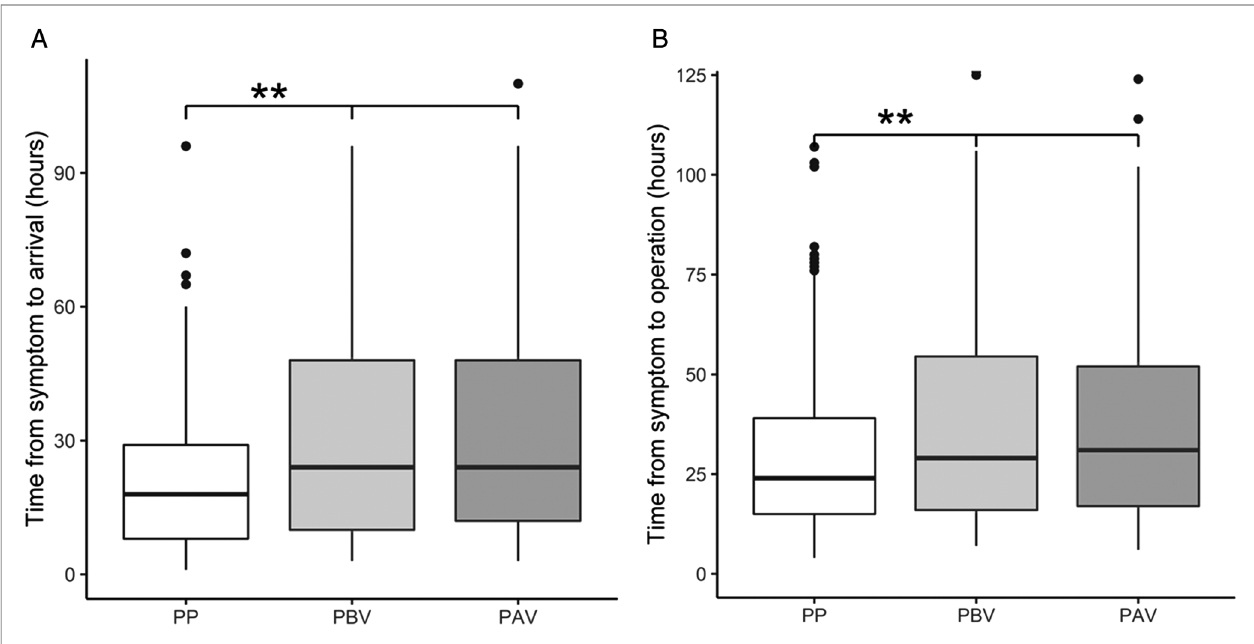
FIGURE 3 | ( A ) Time from symptom to arrival between the three groups. ( B ) Time from symptom to operation between the three groups. ** statistically signi fi cant between two groups in post-hoc analysis. PP, pre-pandemic; PBV, pandemic (before vaccination); PAV, pandemic (after